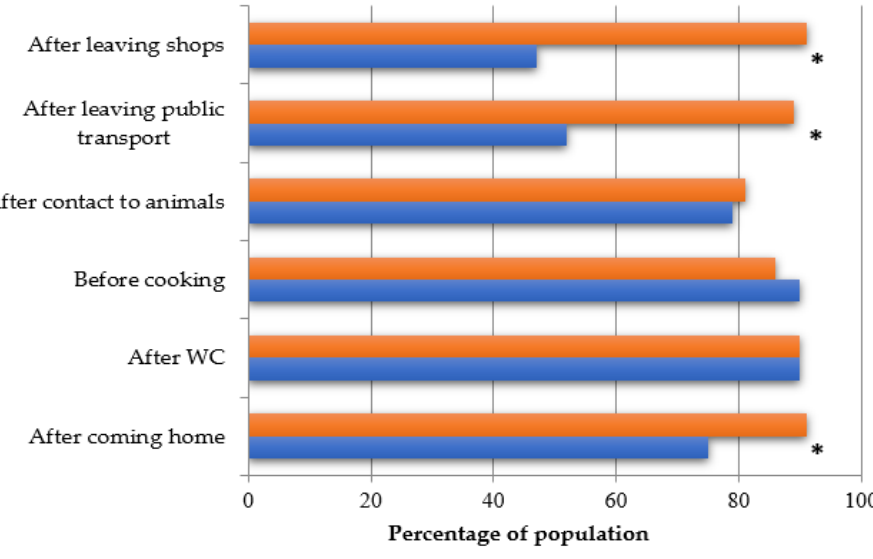
Figure 3. Frequency of hand washing / antibacterial agent use before and during the COVID-19 pandemic. Differences between “before” and “during” the COVID-19 period were evaluated by the Chi-square test (* p < 0.001).